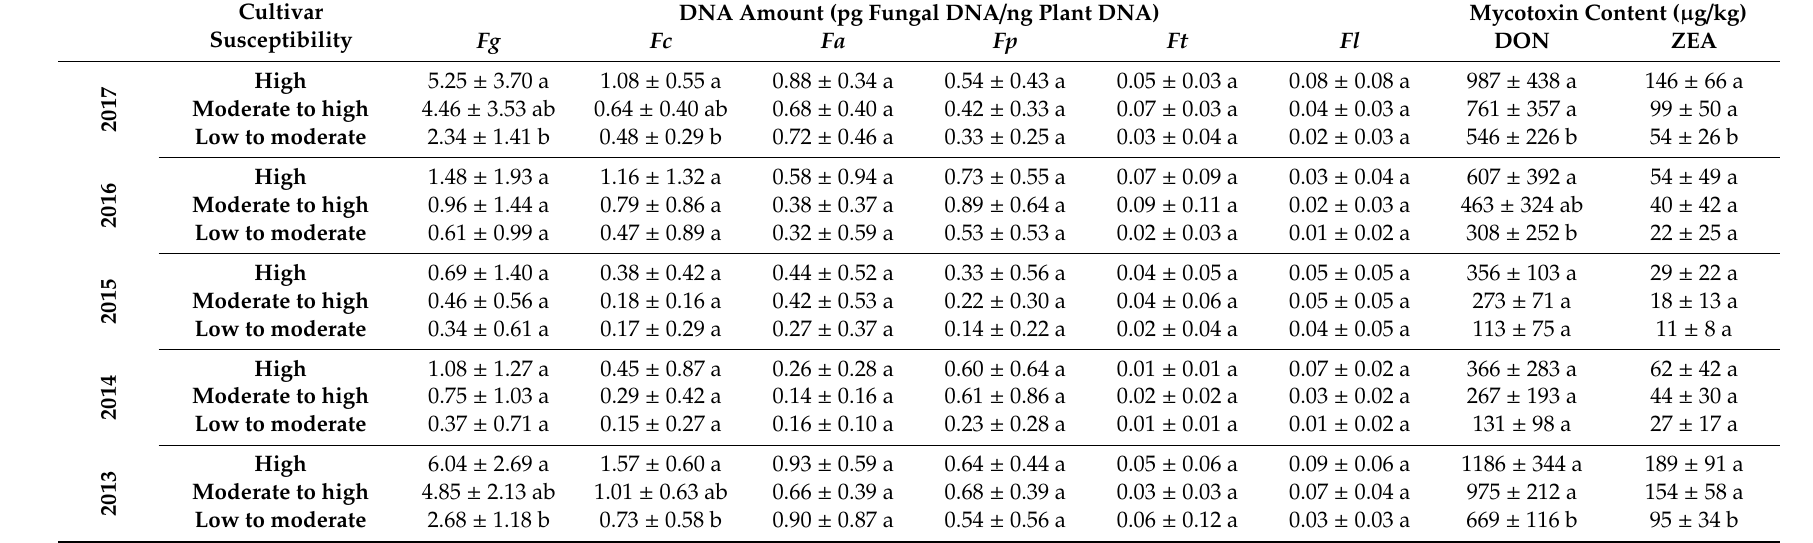
Table 5. Mean DNA amounts ( ± SD ) of F. graminearum ( Fg ), F. culmorum ( Fc ), F. avenaceum ( Fa ), F. poae ( Fp ), F. tricinctum ( Ft ) and F. langsethiae ( Fl ) (pg fungal DNA / ng plant DNA) and mean concentrations ( ± SD ) of DON and ZEA ( µ g / kg) in wheat grain of the highly, the moderately to highly and the lowly to moderately susceptible cultivar of the seven trial locations (three replications per location) in northern Germany from 2013 to 2017. Mean values labelled with the same letter are not significantly di ff erent from each other ( p > 0.05). Di ff erent letters describe di ff erences between the three cultivars for each Fusarium species, DON and ZEA concentrations within a year. n =